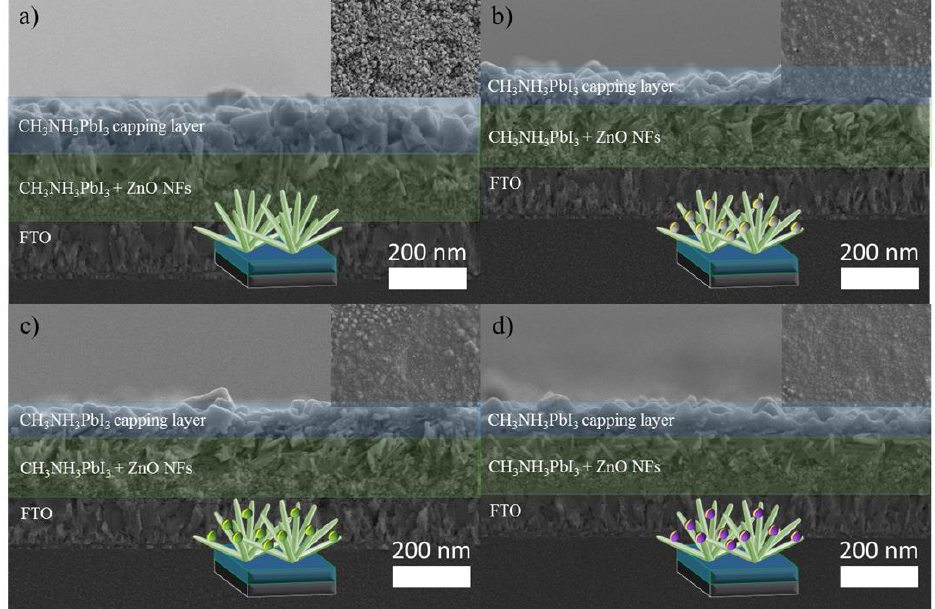
Figure 5. Images of SEM cross-sections and the respective surface morphology inset of CH 3 NH 3 PbI 3 (perovskite) deposited on ( a ) ZnO NFs, ( b ) ZnO − Ag7, ( c ) ZnO − Cu7, and ( d ) ZnO − Ti7. (perovskite) deposited on ( a ) ZnO NFs, ( b ) ZnO-Ag7, ( c ) ZnO-Cu7, and ( d )